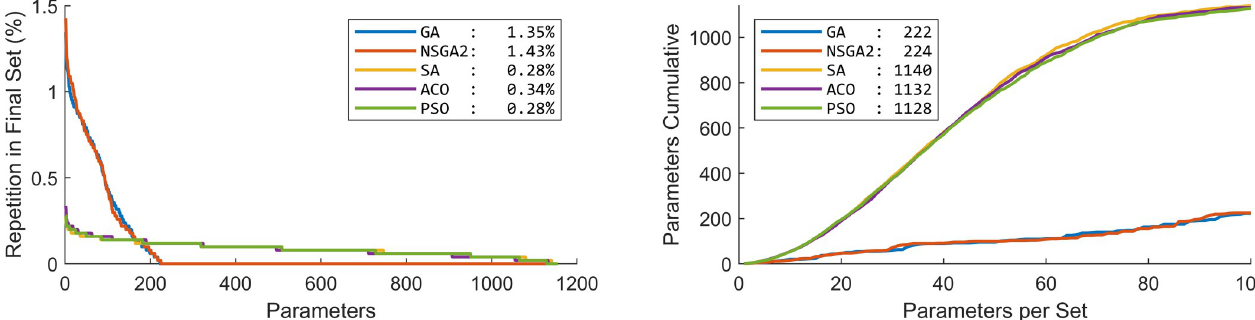
Fig 5. Distribution of different parameters over the 100 subsets of parameters. (a) Percentage of presence of the 1155 parameters. In the Statistical method, which is not present in the plot, the first parameter was repeated in all the 100 subsets. Numbers in the legend show the percentage repetition of the most repeated parameter. (b) Cumulative number of unique parameters over the 100 subsets of parameters. This plot shows that GA and NSGA2 concentrated on a small number of parameters, while the SA, ACO and PSO selected a more diverse range of parameters in the optimization. Numbers in the legend show the number of utilized parameters in the final solution of the 100 subsets of parameters. GA: Genetic algorithm; NSGA2: Nondominated sorting genetic algorithm II; ACO: Ant colony optimization; SA: Simulated annealing; PSO: Particle swarm optimization.